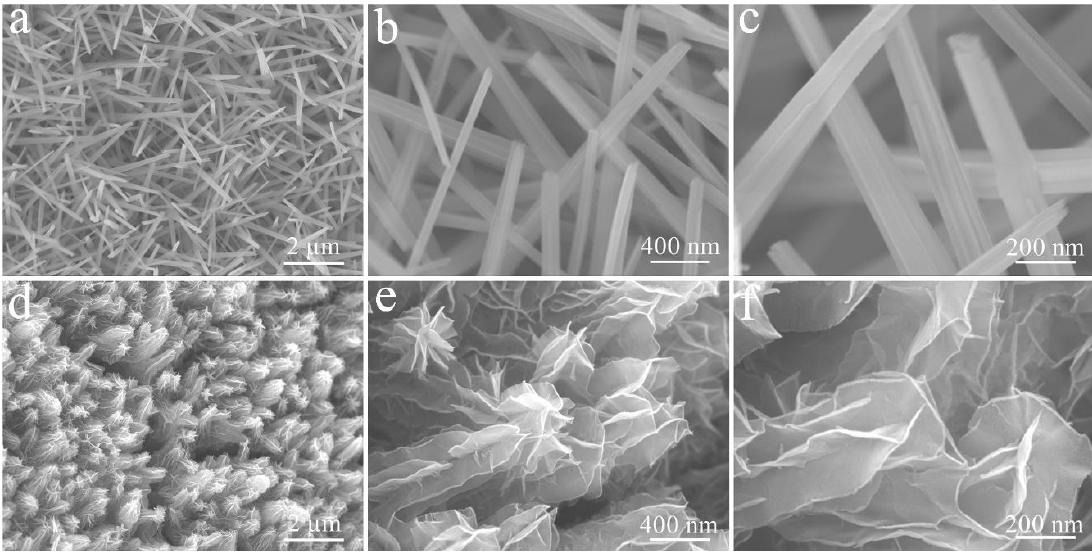
Figure 2. XRD patterns of Cu(OH) 2 and Cu(OH) 2 /NCS ( a ). XPS spectra of Cu 2p ( b ), Ni 2p ( c ), Co 2p ( d ), O 1s ( e ), and S 2p ( f ).